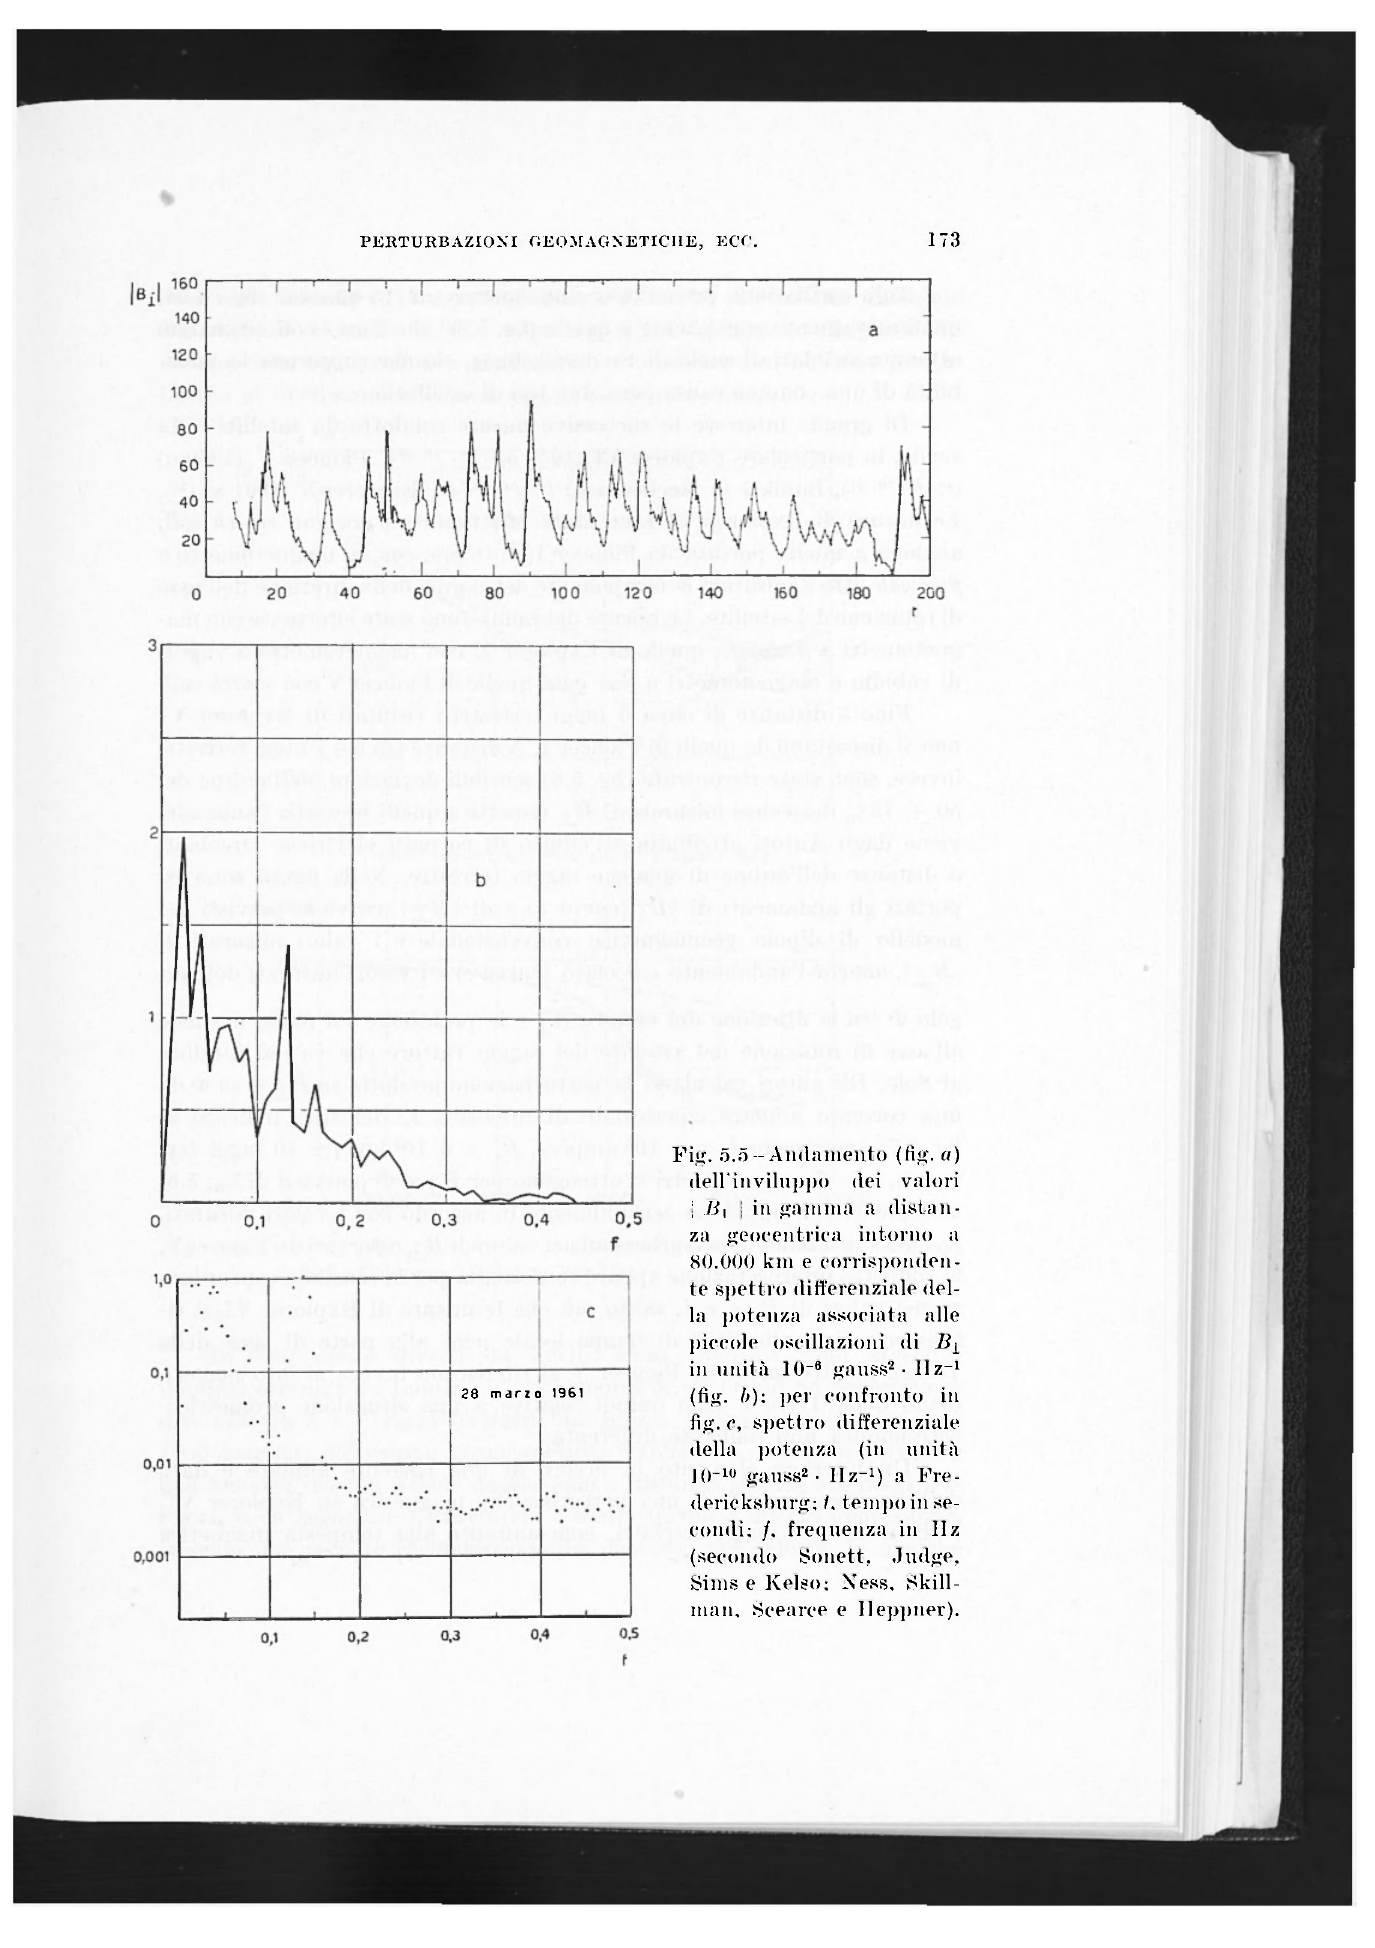
Fig. 5.5-Andamento (fig. a)